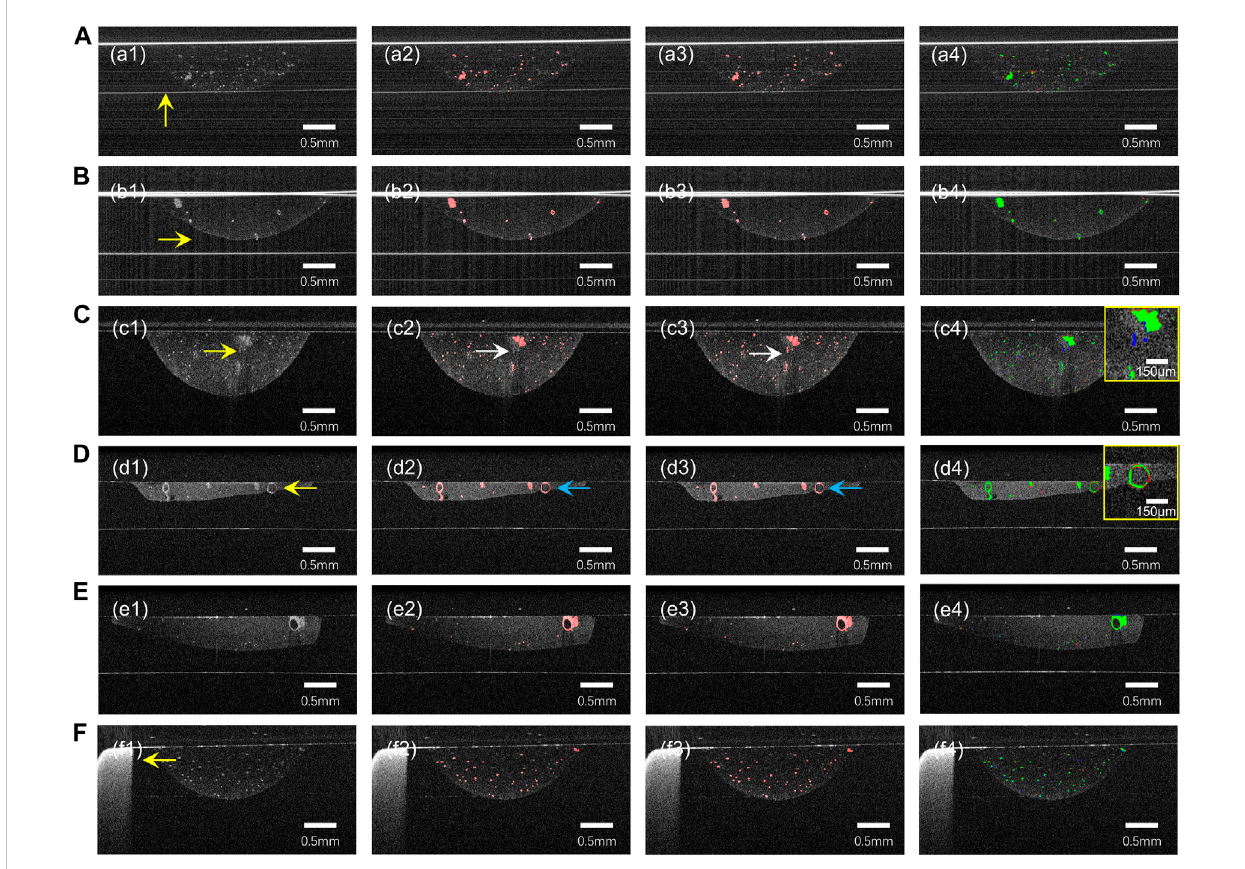
FIGURE 3 The prediction results of our model for some challenging cases of B-Scan. (A) autocorrelation noise; (B) strong re fl ection noise; (C,D) low contrast andblurredboundaries; (E) differentdensityandmorphologyoforganoid. (F) Wellplates.(a1) – (f1)areOCTimages,(a2) – (f2)aregroundtruth,(a3) – (f3)are neural network prediction results, and (a4) – (f4) are fusion results (green) of ground truth (red) and prediction results (blue). The yellow arrows indicate possible problems in the OCT images. The white arrow in row 3 points out that Matrigel was misclassi fi ed as an organoid. The blue arrow in row 4 points out that the organoid was not successfully